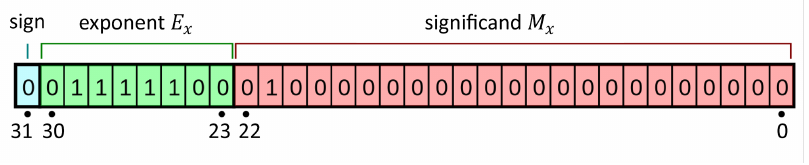
Figure 2. Storage format of floating point